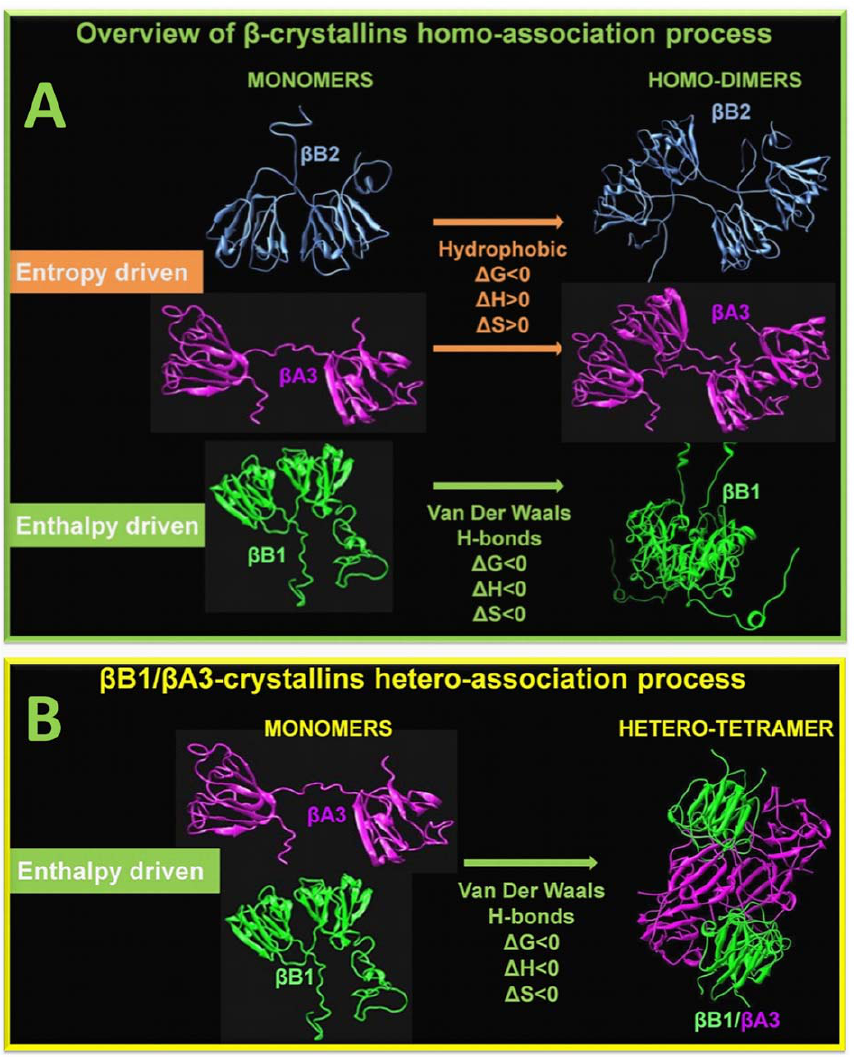
Figure 2. Overview of the homo- and heteromolecular associations of b -crystallins. Top panel: b A3, b B1, and b B2 self-associate in a reversible manner to form dimers. The homo-associations of b A3 and b B2 exhibit endothermic enthalpy and are driven by entropy as a result